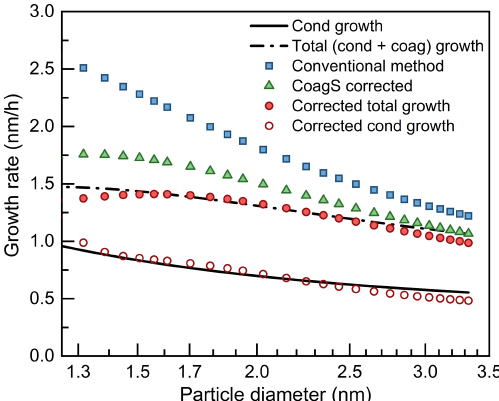
Figure 5. The impact of coagulation sink (CoagS) and coagulation source (CoagSrc) on the appearance time method and the contribu- tion of coagulation growth. The terms cond and coag are short for condensation and coagulation, respectively. Note that both the solid and dashed lines are theoretical growth rates and their difference is the coagulation growth. Similarly, both the open and filled circles are the measured growth rates after correction and their difference is equal to the coagulation growth rate.